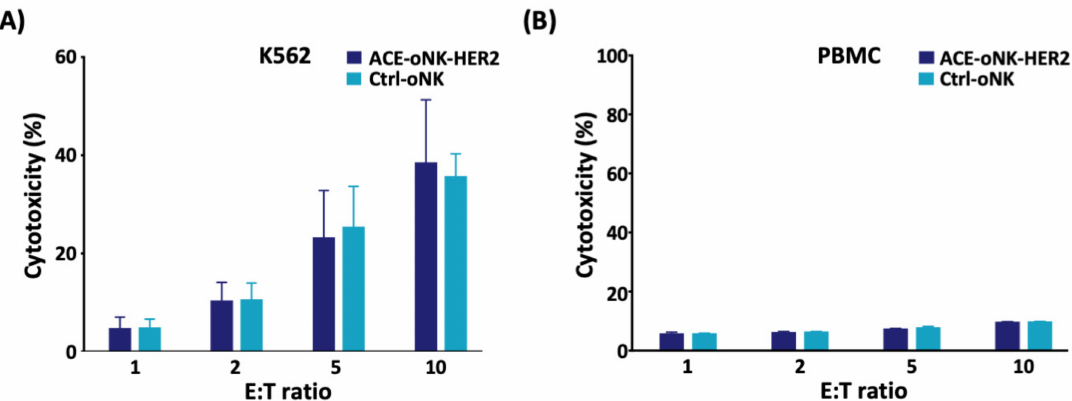
Figure 3. ACE-oNK-HER2 and Ctrl-oNK show no difference of cytotoxicity against HER2-negative cells. ACE-oNK-HER2 and Ctrl-oNK were co-incubated with CFSE-labeled HER2-negative ( A ) K562 human chronic myelogenous leukemia cell line or ( B ) female PBMC at effector to target a (E:T) ratio of 1:1 to 10:1. The viability of CFSE-labeled K562 and PBMC was examined using propidium iodide staining and analyzed by flow